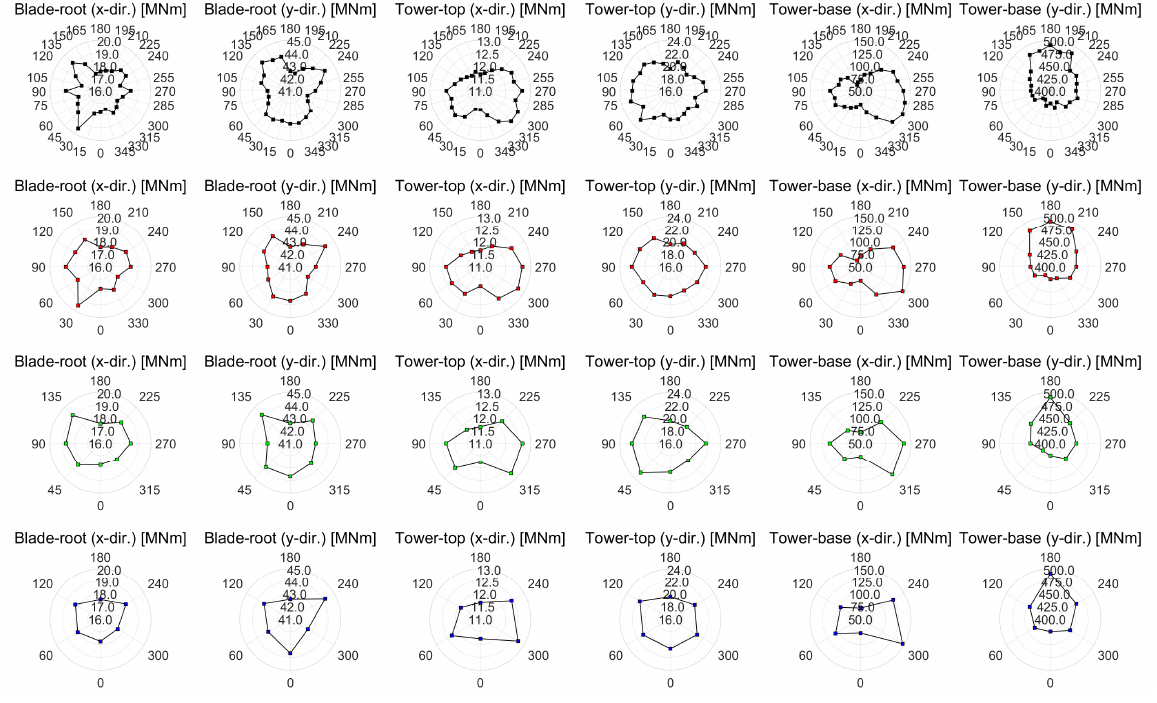
Figure 14. Maximum values of the platform’s motion according to the interval angles.